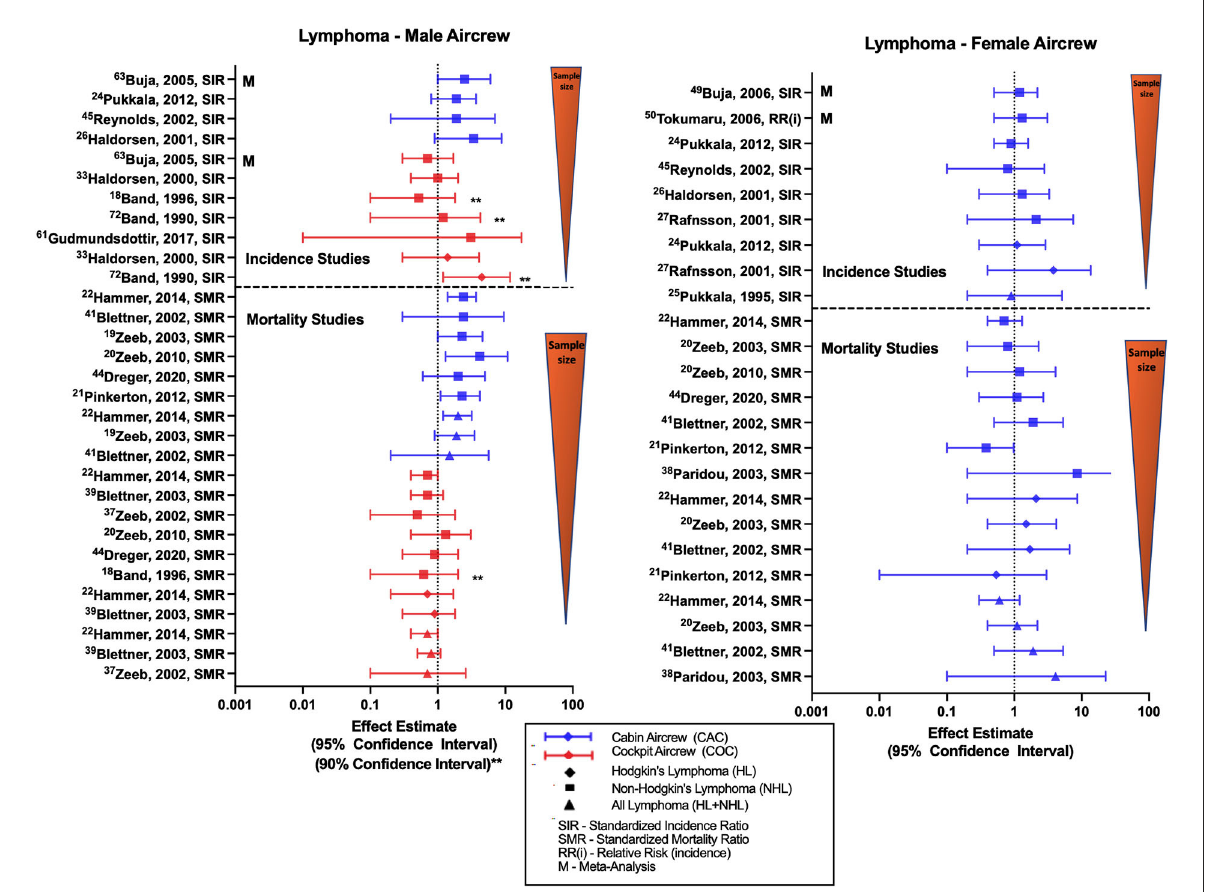
FIGURE5 Forest plot for studies evaluating lymphoma incidence or mortality ratios among male (left hand side graph) and female aircrew (right hand side graph) in association to CIR exposure.